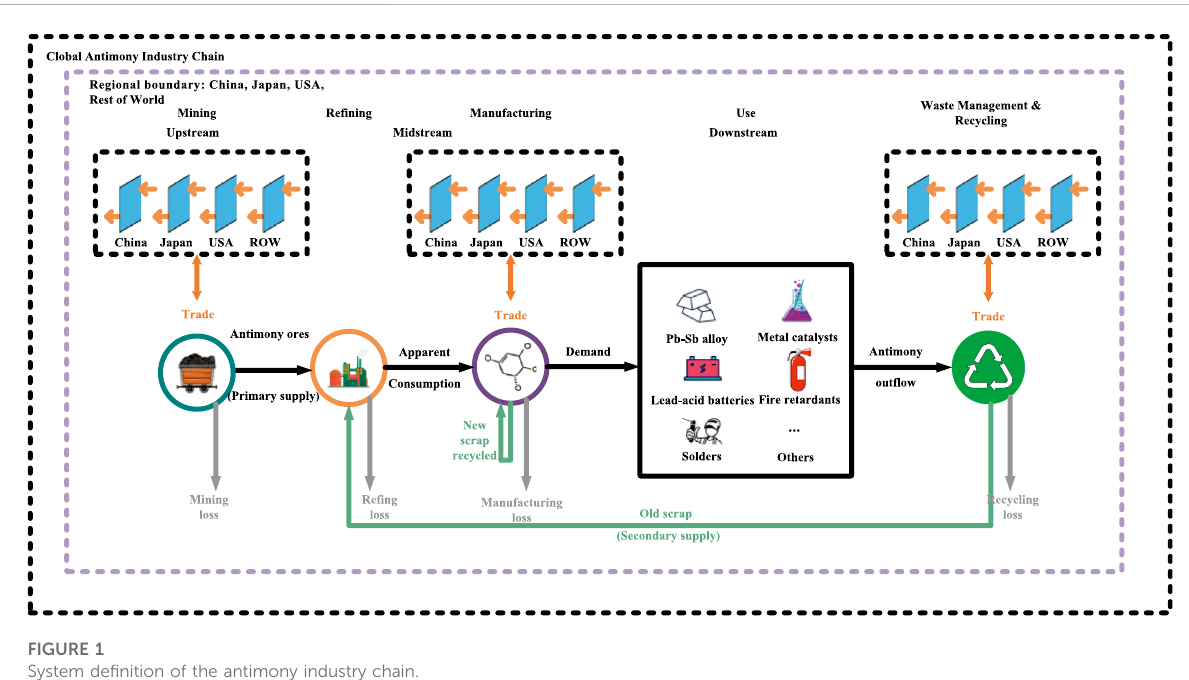
FIGURE 1 System de fi nition of the antimony industry